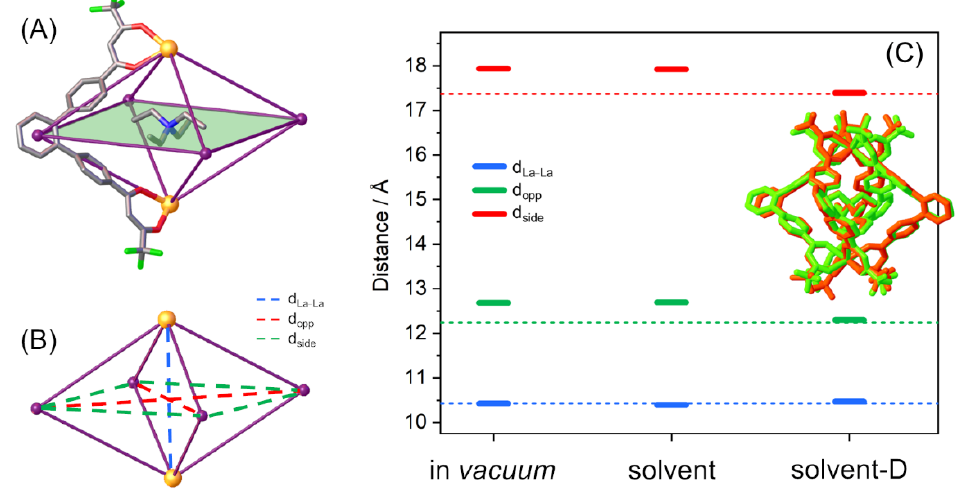
Figure 3. ( A , B ) Schematization of the cages as a pseudo-octahedron: ( A ) NEt 4 ⊂ C1 cage with the equatorial plane highlighted in green, where three ligands were omitted to highlight the pseudo- octahedral geometry and ( B ) octahedral structure. The dashed lines indicate the three different distances: along the axial direction (d La–La , blue) and on the equatorial plane (d opp , red, and d side , green). ( C ) The solid bars represent the calculated values for the different distances along the axial direction (d La–La , blue) and on the equatorial plane (d opp , red, and d side , green). The dashed lines indicate the SCXRD data values [24]. Distances are in Å. In the inset, the overlap between the SCXRD structure (orange) and the geometry optimized with solvent and dispersion correction (green).